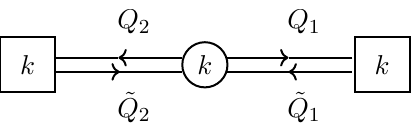
Figure 1 . The quiver diagram of N = 2 superconformal